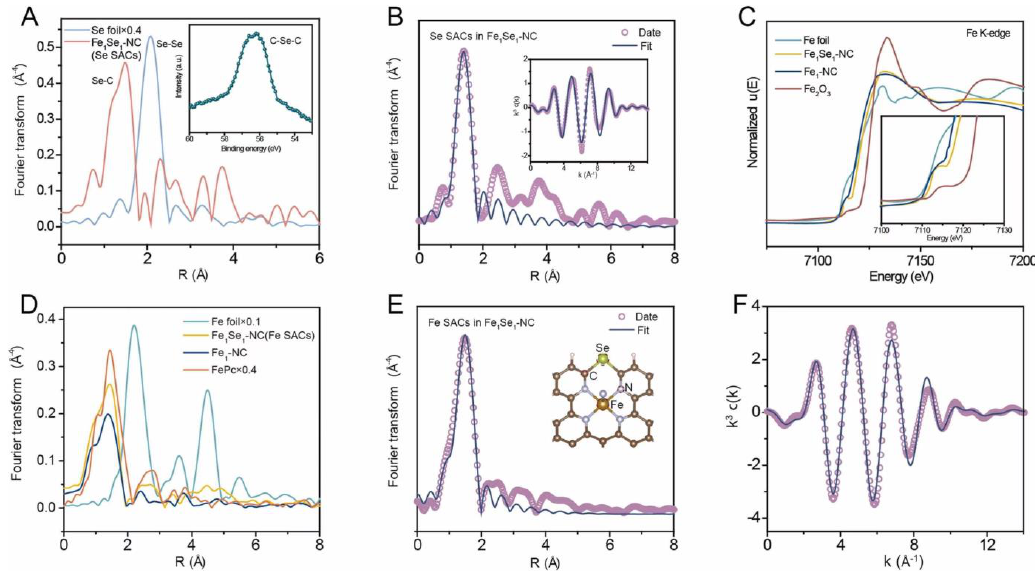
Figure 11. Multispectral characterization of the catalyst: ( A ) EXAFS spectrum of Se K edge in Fe 1 Se 1 -NC; ( B ) EXAFS fitting curve in R space and K space of Se monoatomic in Fe 1 Se 1 -NC catalyst; ( C ) K − edge XANES spectra of Fe in Fe 1 Se 1 -NC and Fe 1 -NC; ( D ) EXAFS spectrum of Fe K edge in R space; Fitting Curve of Monoatomic Fe in R Space and K Space in ( E , F ), Fe 1 Se 1 -NC Catalysts. (Reprinted with permission from [124]. Copyright 2022, Elsevier).